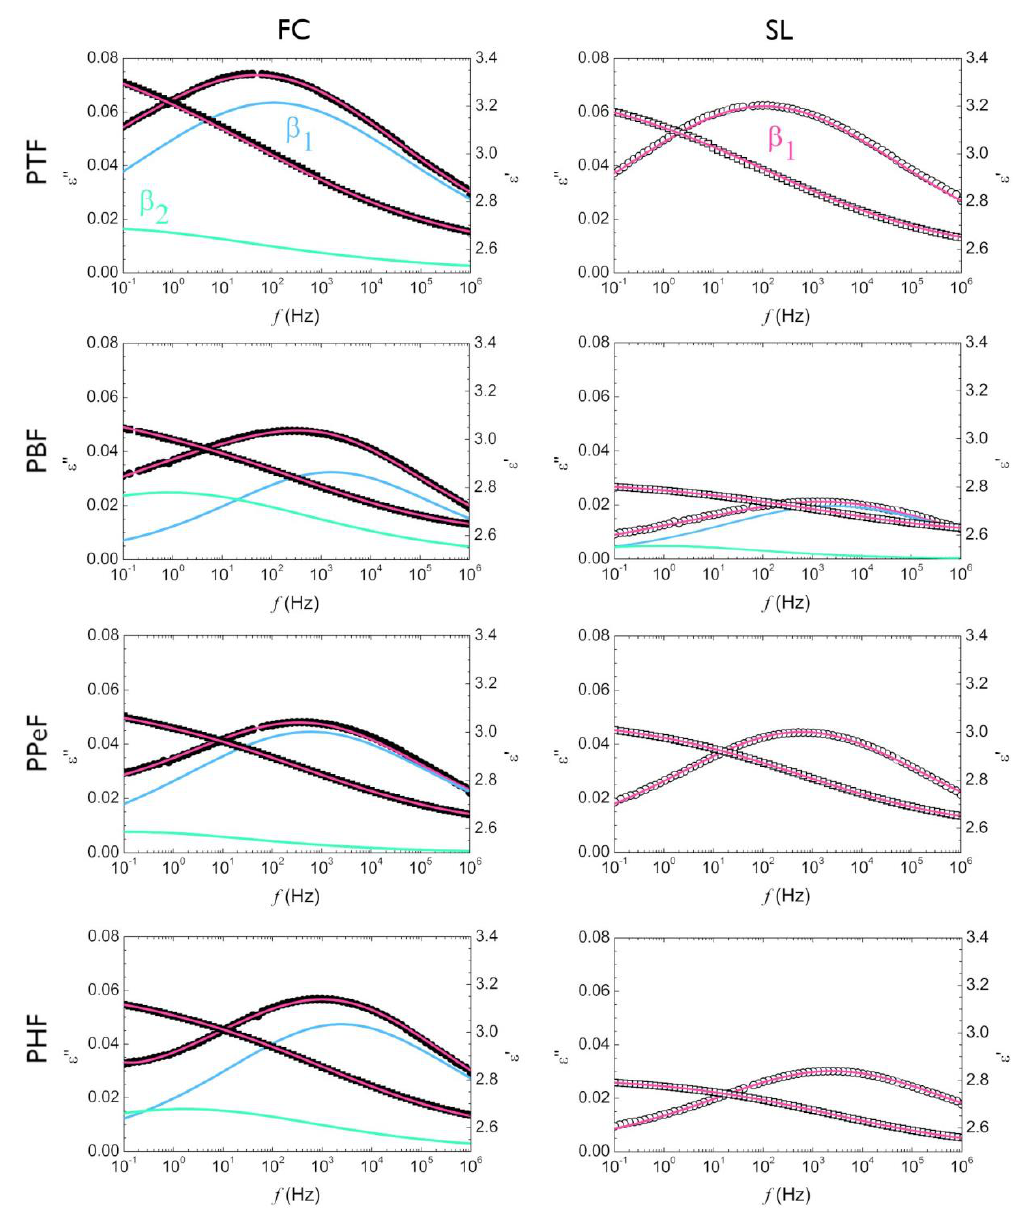
Figure 1. Broadband dielectric spectroscopy (BDS) results at 228 K. Circles correspond to ε’’ and squares correspond to ε’. The fittings were carried out following Equation (1). Solid pink lines correspond to the total fit, while blue and green lines show the components of β 1 and β 2 , respectively. The data corresponding for fast-cooled (FC)-PBF was adapted from Ref [28].